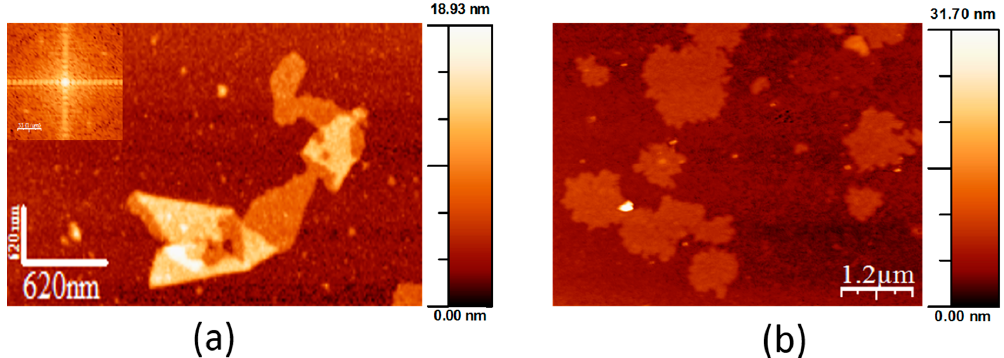
Figure 4. AFM micrographs of the wild-type S-layer of S. ureae ATCC 13881 (SslA). ( a ) Extraction of the wild-type SslA from the cell surface by a chemical treatment resulted in folded mono- and multi-layered patches that exhibit p4 symmetry and ( b ) after monomerization with GuHCl and in vitro recrystallisation at pH = 3 on a functionalised silicon wafer, wild-type SslA self-assembled into small, rough-edged patches. Protein recrystallisation on surfaces is a complex process. In general terms, any recrystallization process has two stages, nucleation and growth [19]. Nucleation is characterised by the appearance of small molecular clusters which, upon appropriate conditions, given that they are big enough, grow up into protein patches. By further incorporation of monomers and the aggregation of patches, layer formation occurs; however, there is always a competitive adsorption and desorption of the monomers